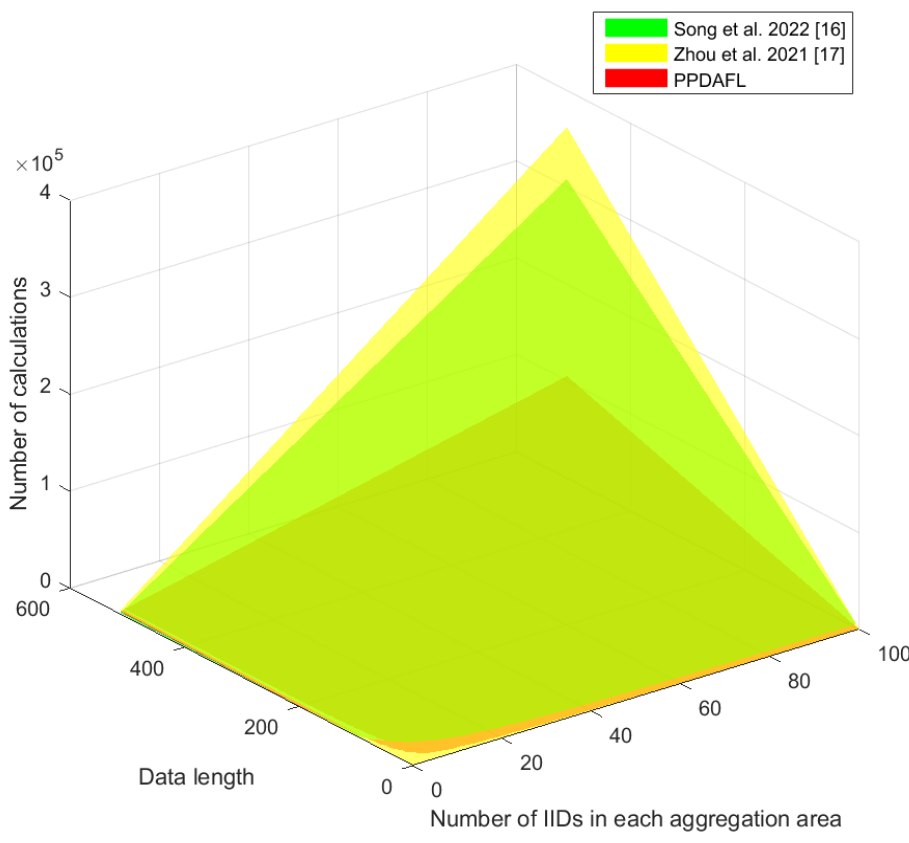
Figure 4. Comparison of communication overhead [16,17].